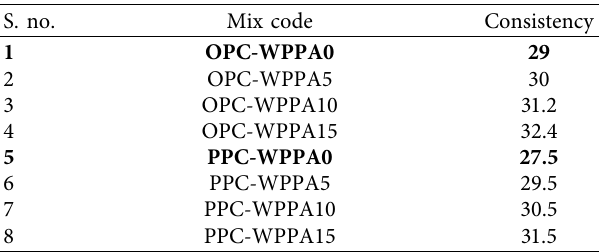
Bold values are the controlling mix (0% paper ash). Table 8: Normal consistency of blended pastes of OPC-WPPA and PPC-WPPA.